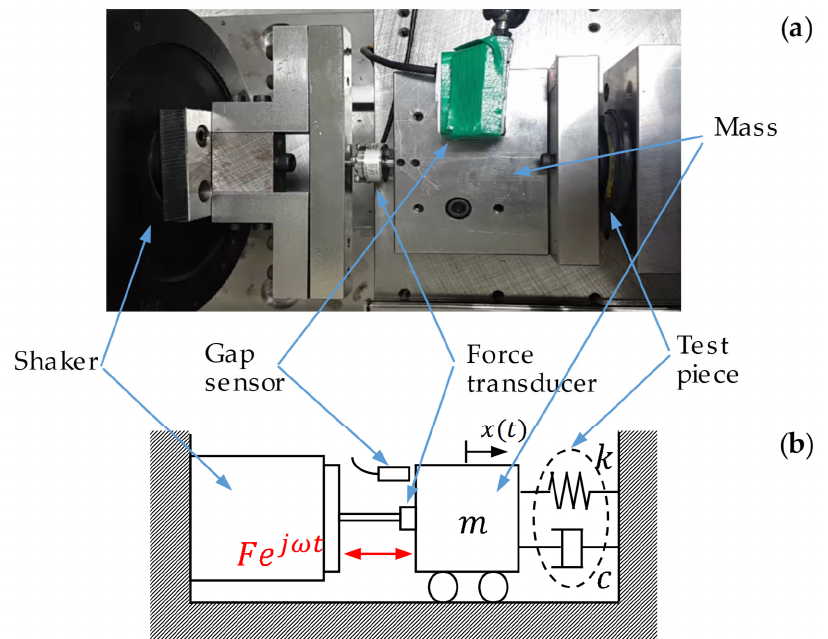
Figure 11. Measurement setup of the stiffnesses and damping coefficients for mounts, rubber bush ‐ ings, and hoses: ( a ) the photo of actual device and ( b ) the corresponding physical model.